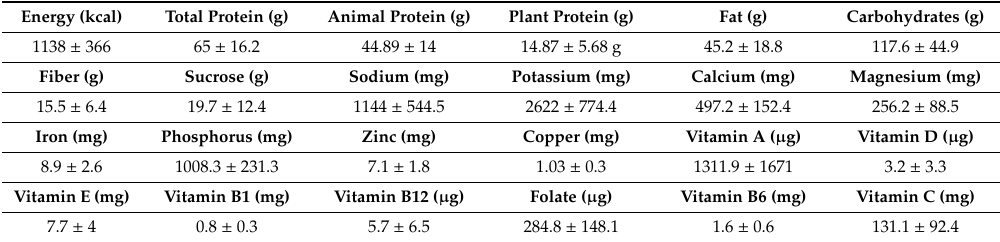
Table 3. Seventy-two-hour nutritional diary log summary.